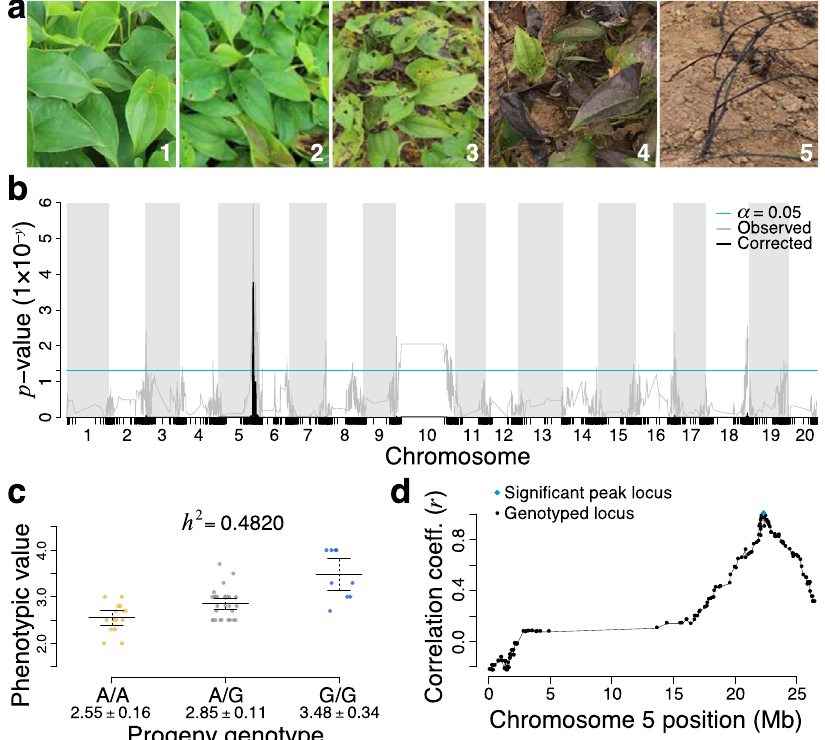
Fig. 3 Quantitative trait locus for anthracnose resistance. a Exemplars of the yam anthracnose disease (YAD) fi eld assessment severity rating scale (scored 1 – 5) used at IITA in Ibadan, Nigeria. b Genome-wide QTL association scan for YAD resistance in the TDa1402 genetic population ( n = 53 biologically independent samples) for the year 2017. A statistically signi fi cant association (corrected p = 1.69 × 10 − 4 ) was found on chromosome 5, at 23.3 Mb. Per-locus Wald statistic-based logistic regression signi fi cance values (gray line) were corrected for multiple testing (black line) via max( T ) adjustment with 1 × 10 6 permutations. The minimum signi fi cance threshold ( α = 0.05) is represented with a cyan horizontal line. c Effect plot for the peak locus on chromosome 5 at 23.3 Mb, the genotypes ( X -axis) of which explain 48.2% of the observed phenotypic variance (i.e., narrow-sense heritability, h 2 ), suggests that an increased dose of the ‘ A ’ allele is associated with lower severity of YAD. Centerline and whisker plots, and their corresponding statistics ( X -axis), represent the mean ± 95% con fi dence intervals. d Plot showing the strength of linkage disequilibrium (LD) between the peak marker (cyan diamond) and other loci (black points) in chromosome 5. LD was calculated as Pearson ’ s correlation ( r ) between alleles. Source data are provided as a Source Data fi